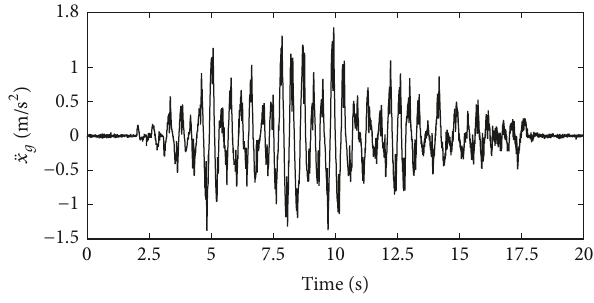
Figure 3: Excitation of the experimental